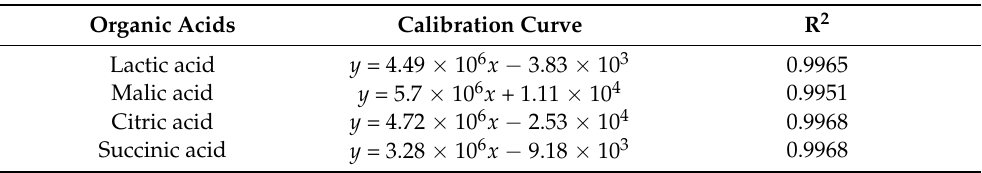
Table 1. Calibration curves of organic acids. Organic